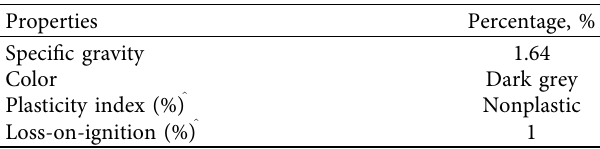
Table 5: RHA properties.